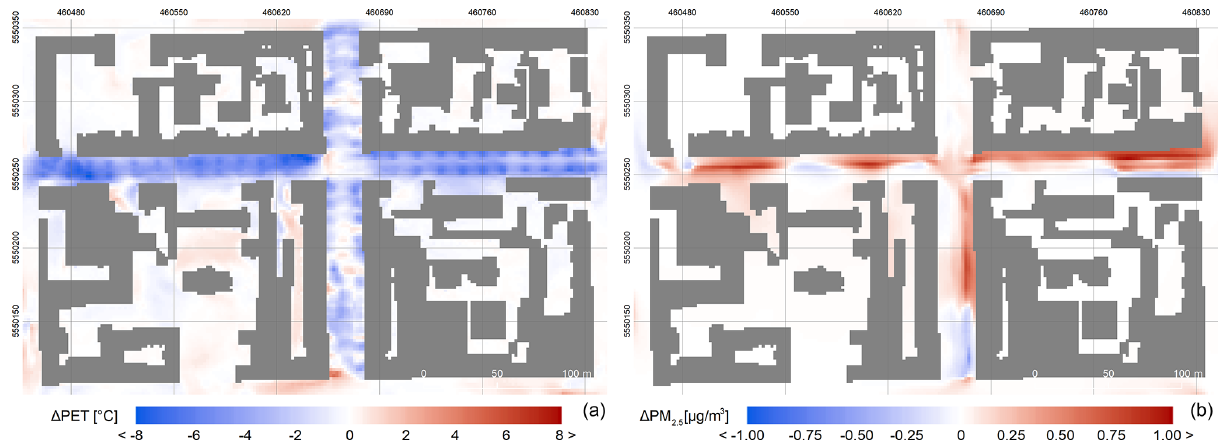
Figure 14. Example of opposite behaviour of thermal comfort and air quality indicators represented by average daily difference in PET and PM 2 . 5 for new-alley scenario